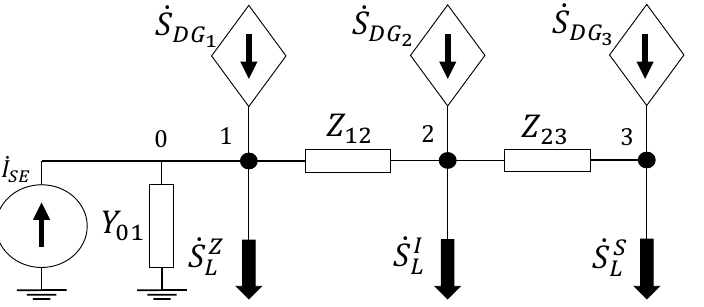
Figure 4. Three-node system with the DG